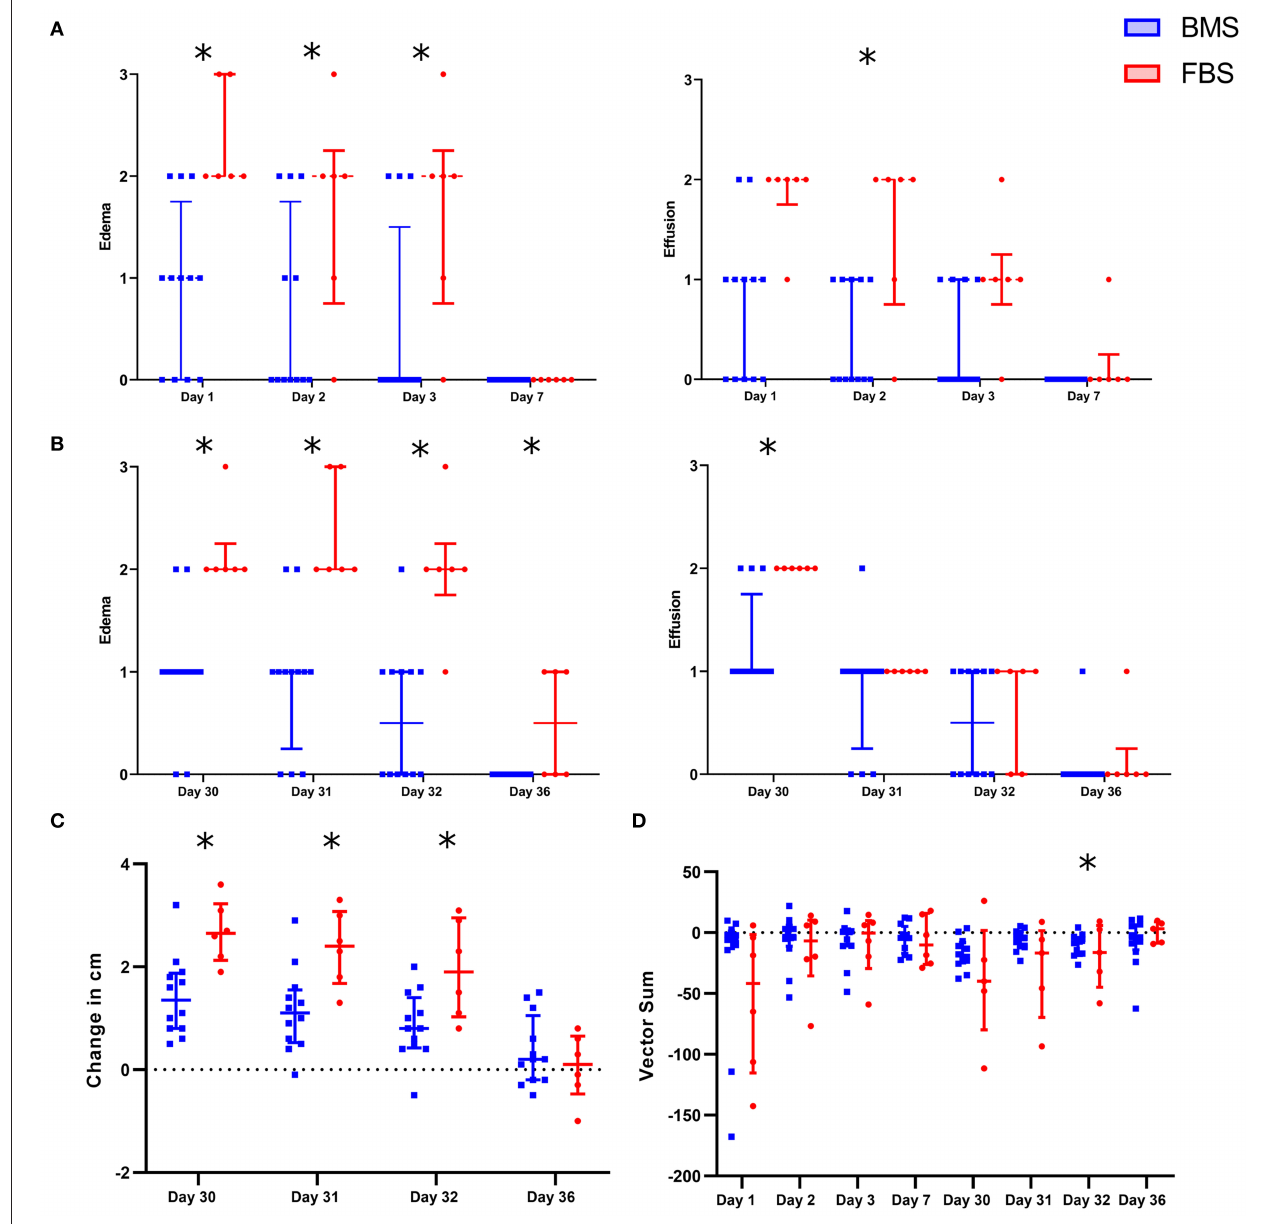
FIGURE 2 | Local adverse response in FBS-MSC recipients compared to BMS-MSC recipients. (A) Peri-articular edema and synovial effusion was worsened in FBS-MSC recipients (significance denoted by asterisks, * p ≤ 0.05). (B) After the second injection, with concurrent administration of LPS, peri-articular edema and synovial effusion was again, worsened in FBS-MSC recipients. (C) Likewise, limb circumference was increased after the second injection in FBS-MSC recipients. (D) There was no difference in gait asymmetry (pain) after the first injection. After the second injection, with concurrent LPS administration, there was a trend of worsened gait asymmetry in FBS-MSC recipients on day 30 and 31, and worsened gait asymmetry on day 32 in FBS-MSC recipients.